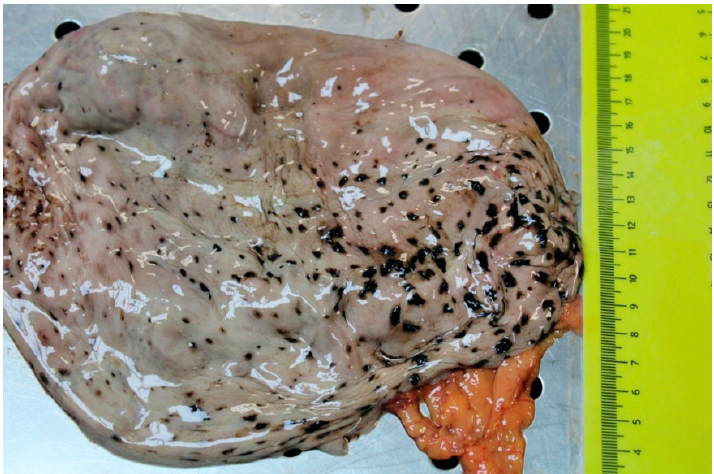
Figure 1. Macro hemorrhages of about 0.4–0.5 cm in diameter spread over the entire surface of the gastric mucosa (Case 3).